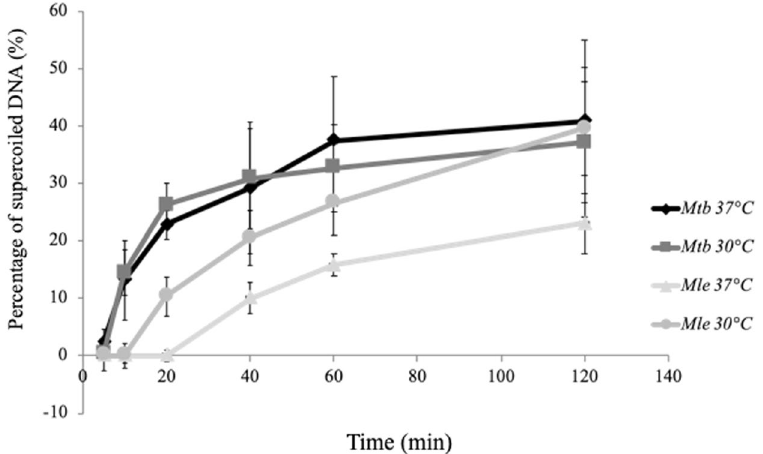
Figure 2. Mle - and Mtb- DNA gyrases were compared by examining ATP-dependent DNA supercoiling activity. Relaxed pBR322 DNA (0.3 μ g) was incubated at 30 °C or 37 °C with DNA gyrase reconstituted from 3 μ M of recombinant GyrA and GyrB. Mixture samples were examined for supercoiling activities at various time points (5, 10, 20, 40, 60, and 120 min) at 30 °C or 37 °C. The reactions were terminated, and the DNA products were analysed by electrophoresis on 1% agarose gels. Data are shown as the means and standard errors of at least three independent experiments; ◆ and ■ , Mtb -DNA gyrase at 37 °C and 30 °C, respectively; ▲ and ● , Mle -DNA gyrase at 37 °C and 30 °C, respectively.